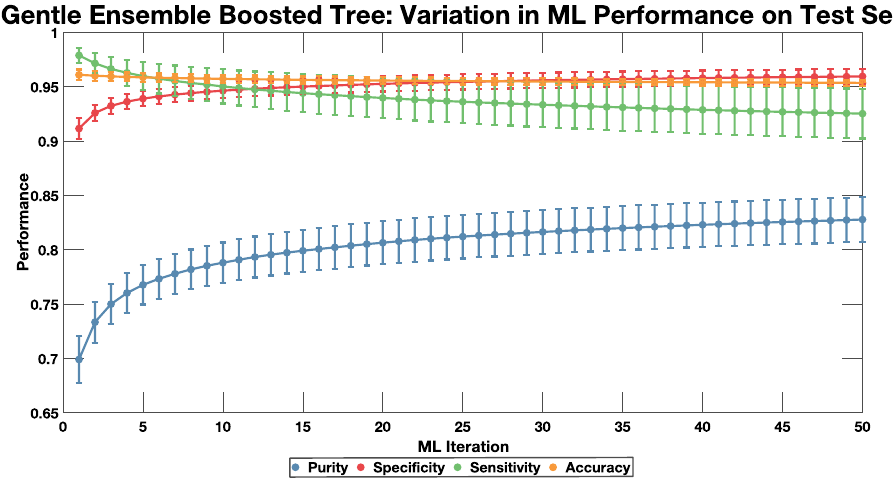
Figure 5. An ensemble of models were trained for classification based on data from 10 days out of a total of 13 days of data. The testing set featured 5 days of unseen data which was formatted identically to the training set. The test set was evaluated in a non-specific sequence with the predictions of first model dictating the inputs into the next model until all 50 models had evaluated the data. As we increased the number of models used, we observed a convergence in performance to a maximal limit. Error bars represent one standard deviation across the 286 ensemble of